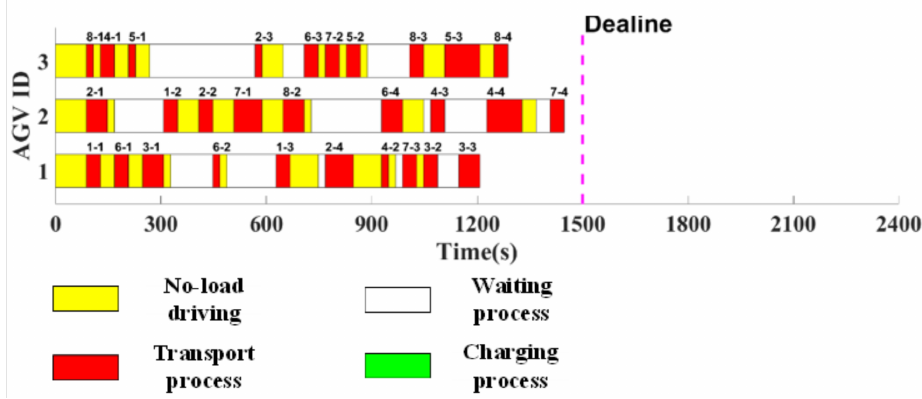
Figure 12. Initial scheduling plan.